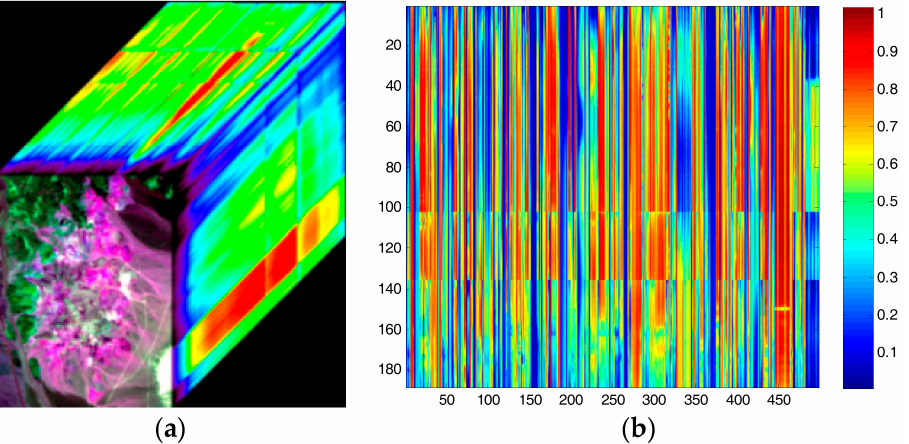
Figure 5. Cuprite dataset. ( a ) R-2. ( b ) Standard spectral library A .